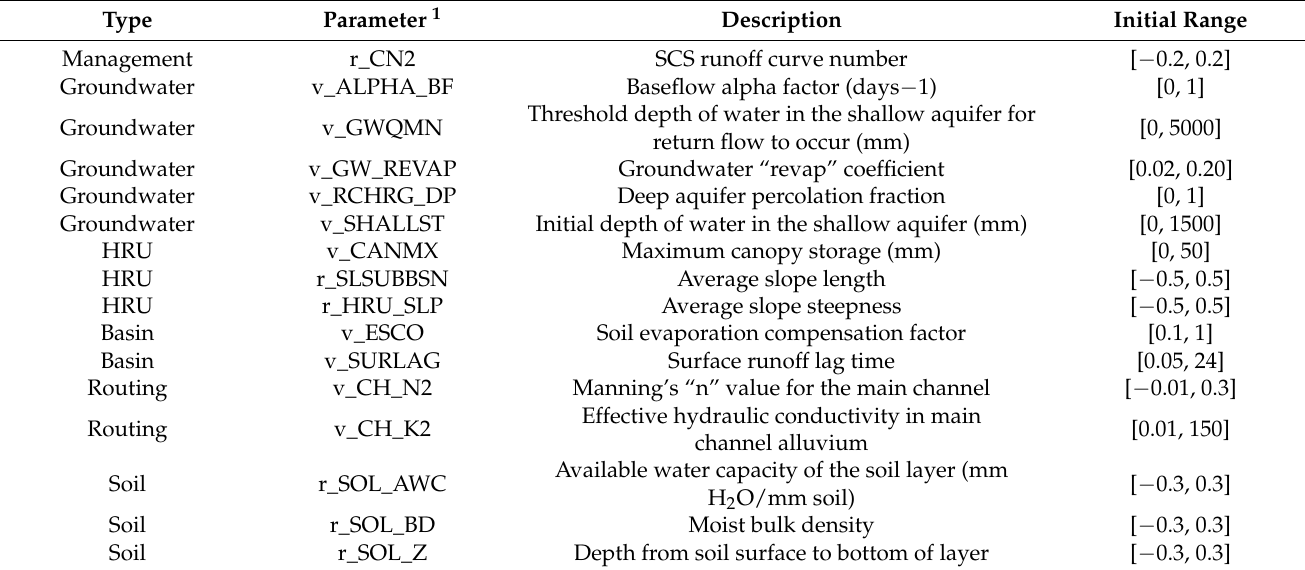
Table 4. SWAT calibration parameters.